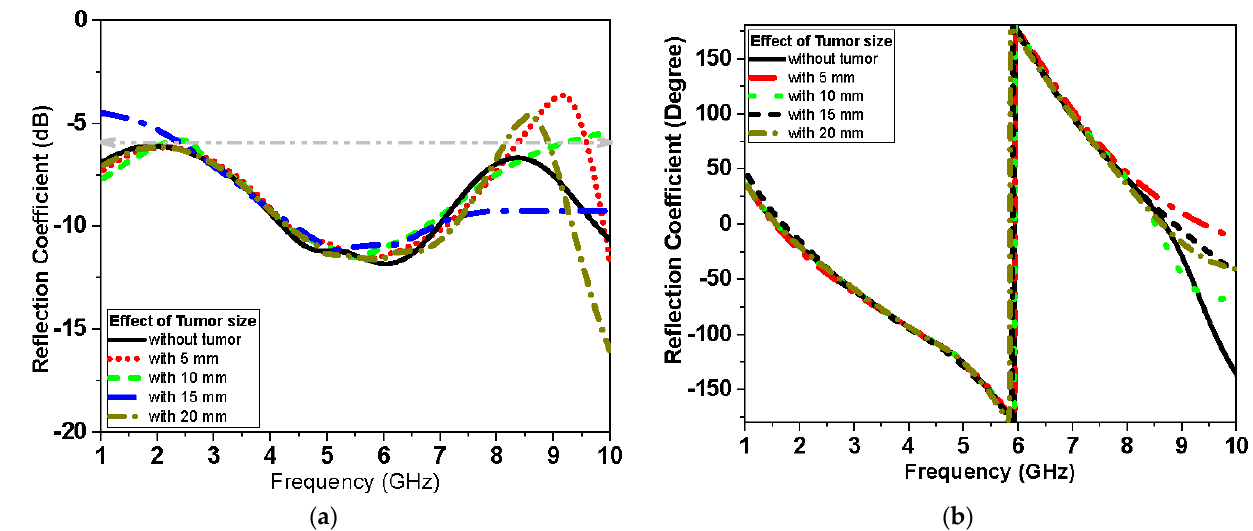
Figure 16. Simulated |S 11 | of proposed monopole textile antenna with and without tumor (second scenario shown in Figure 14b) at different sizes of tumor: ( a ) magnitude in dB and ( b ) phase in degrees.